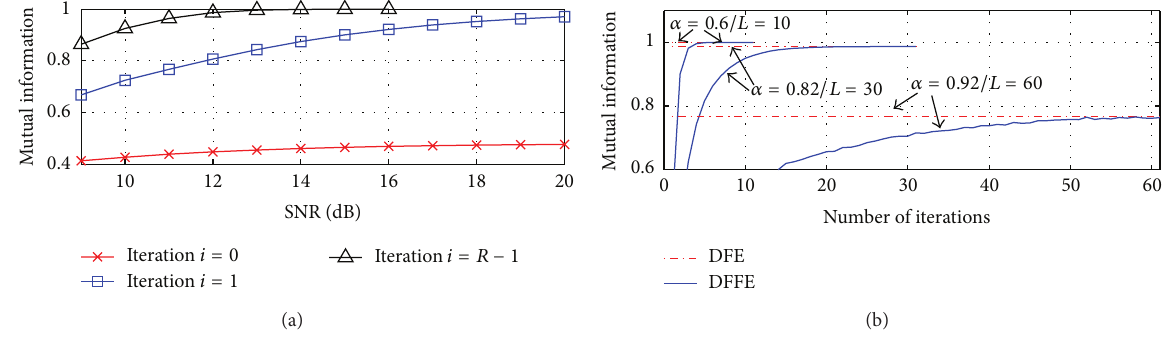
Figure 2: Reliability of the DFFE tentative decisions. (a) Mutual information versus SNR for 𝛼 = 0.6 , 𝐿 = 10 , and 𝑅 = 11 . (b) Mutual information versus number of iterations for different postcursor channels with SNR = 15